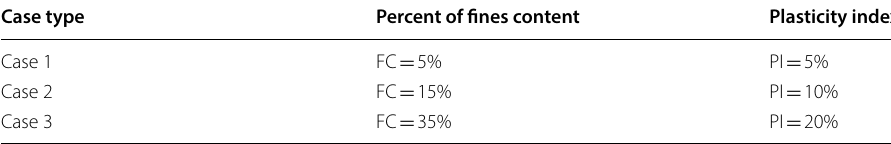
Table 1 Considered cases for fines content and plasticity index Case